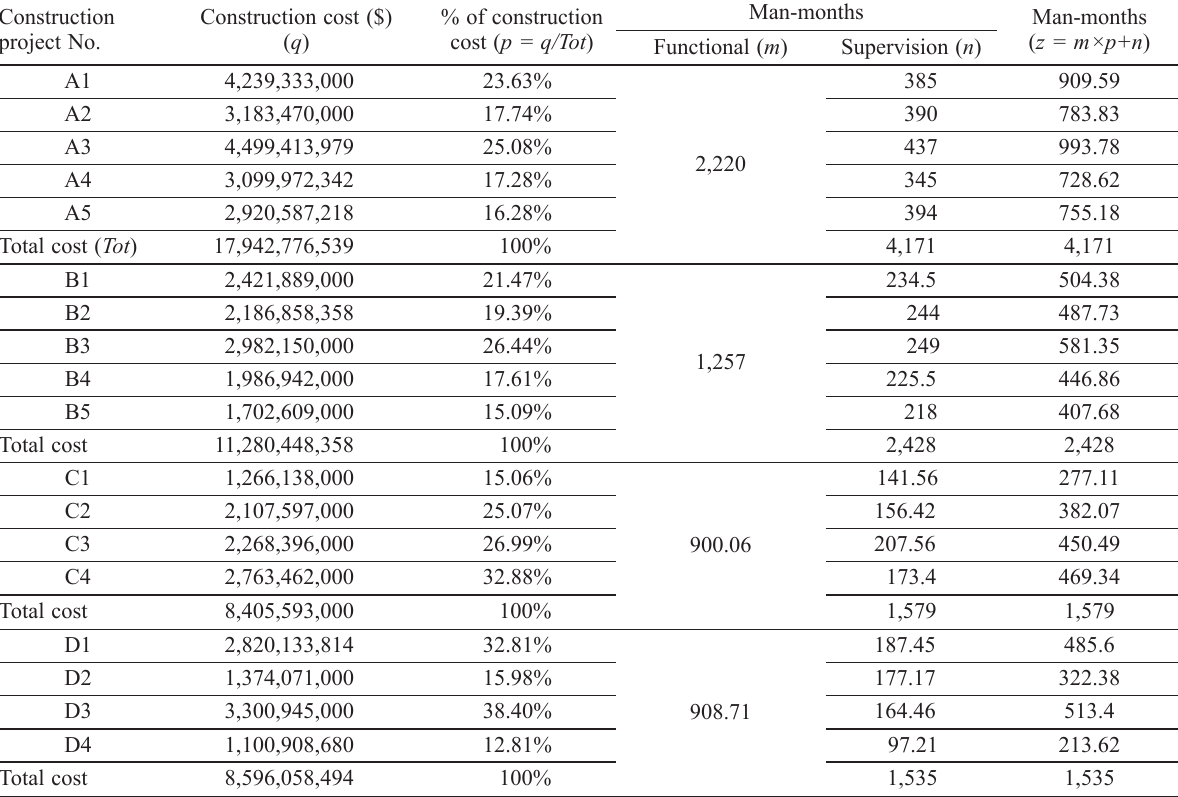
Table 3. Man-months allocated to each construction project of four mega supervision projects Construction project